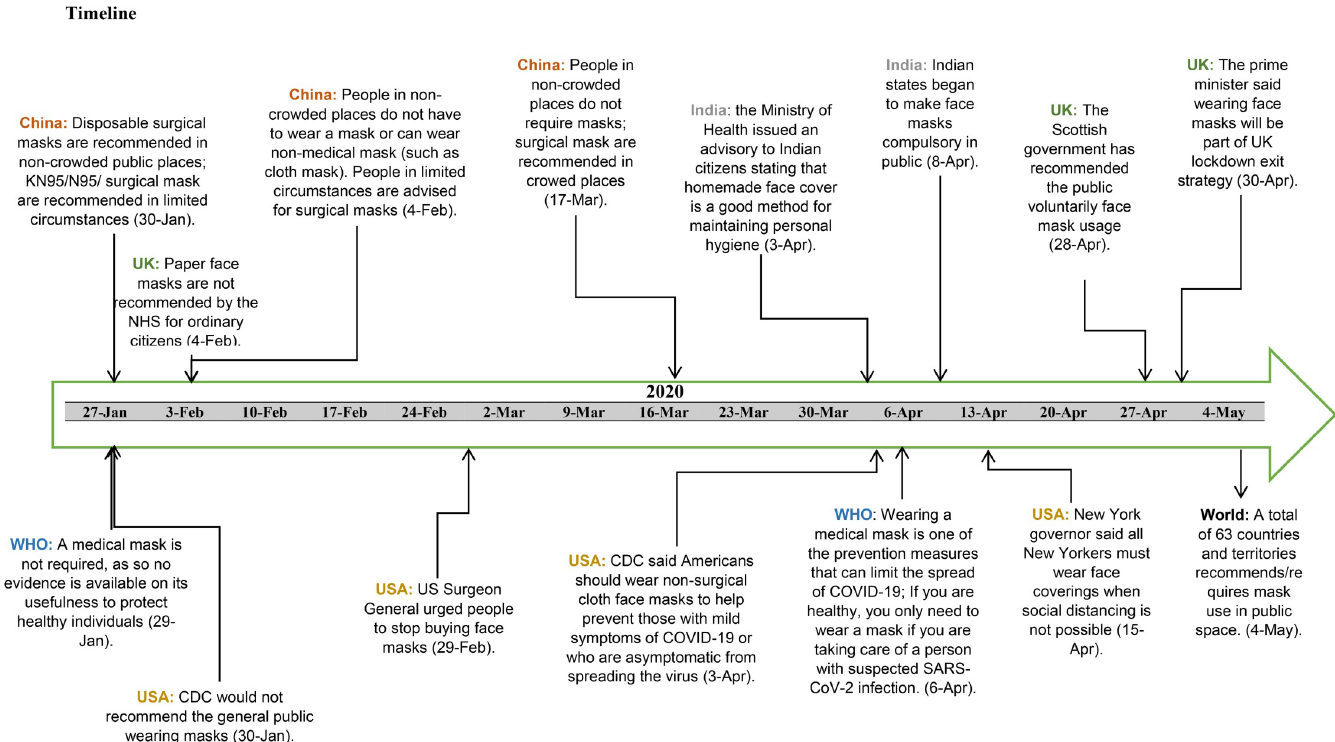
Fig 1. Timeline of policy recommendations for face mask usage by WHO and key